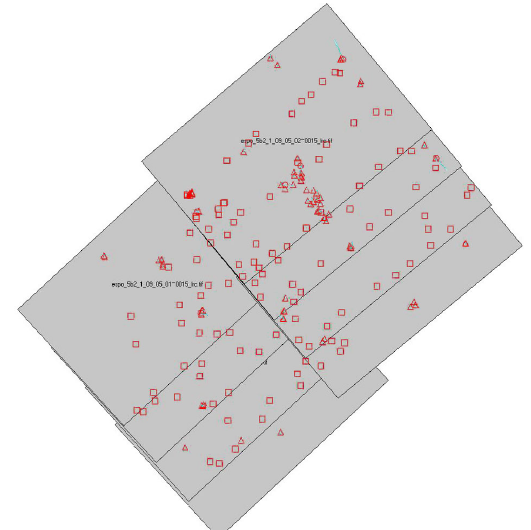
Figure 2. The distribution of tie points and ground control points within the image block. Only four images from the middle of the block were included in the research.